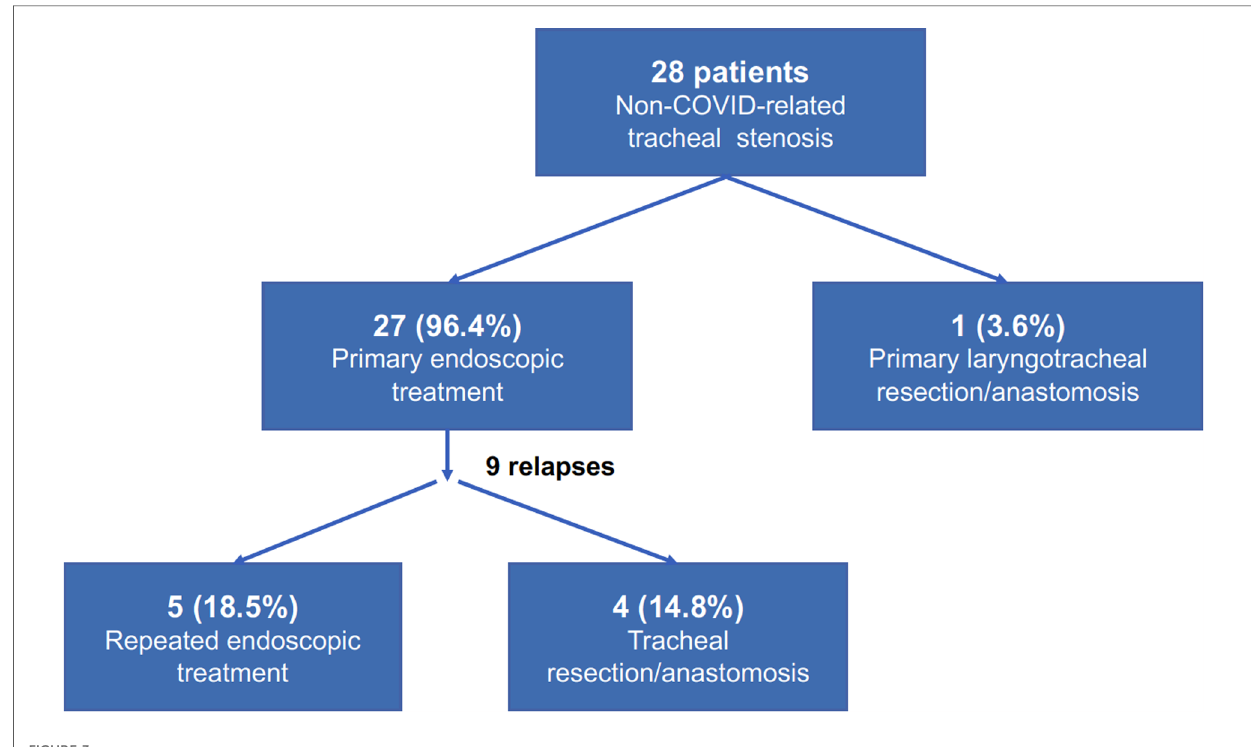
FIGURE 3 Treatment algorithm and outcomes in our patients with non-COVID-related tracheal